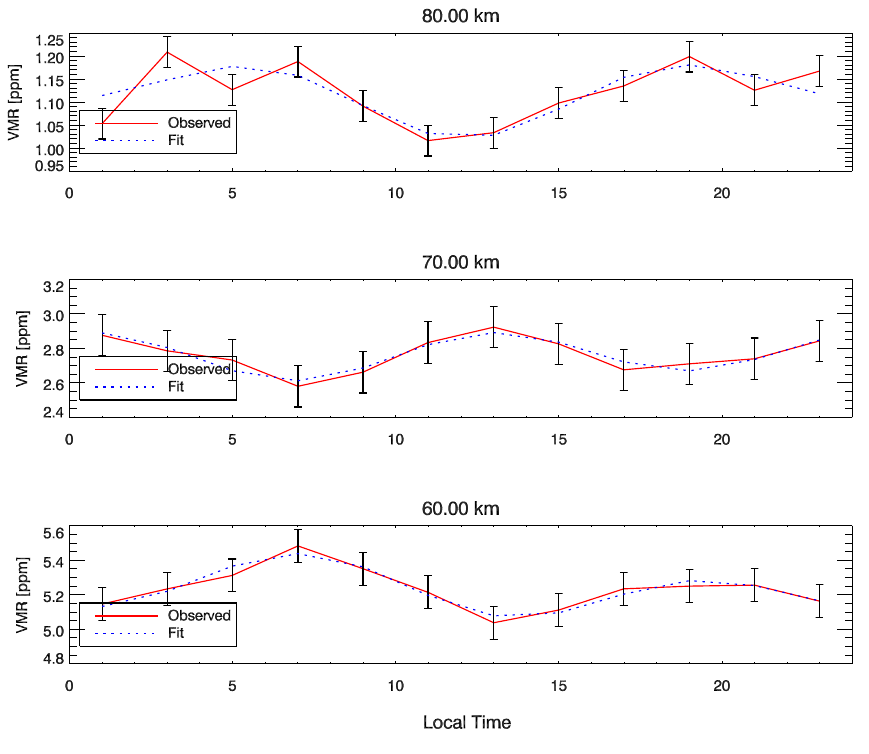
Fig. 2. The volume mixing ration as a function of local time for the eight topmost layers during December 2008. The vertical difference between each layer is 10km. The solid line is the measured variability and the dotted line is the fit according to Eq. (1.)